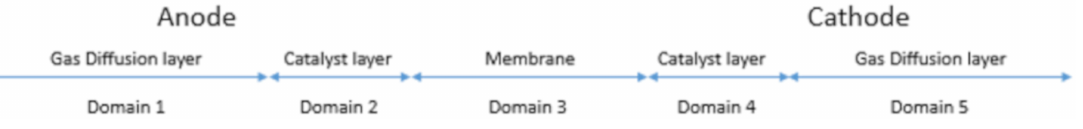
Figure 2. The geometry of the one-dimensional PEFC